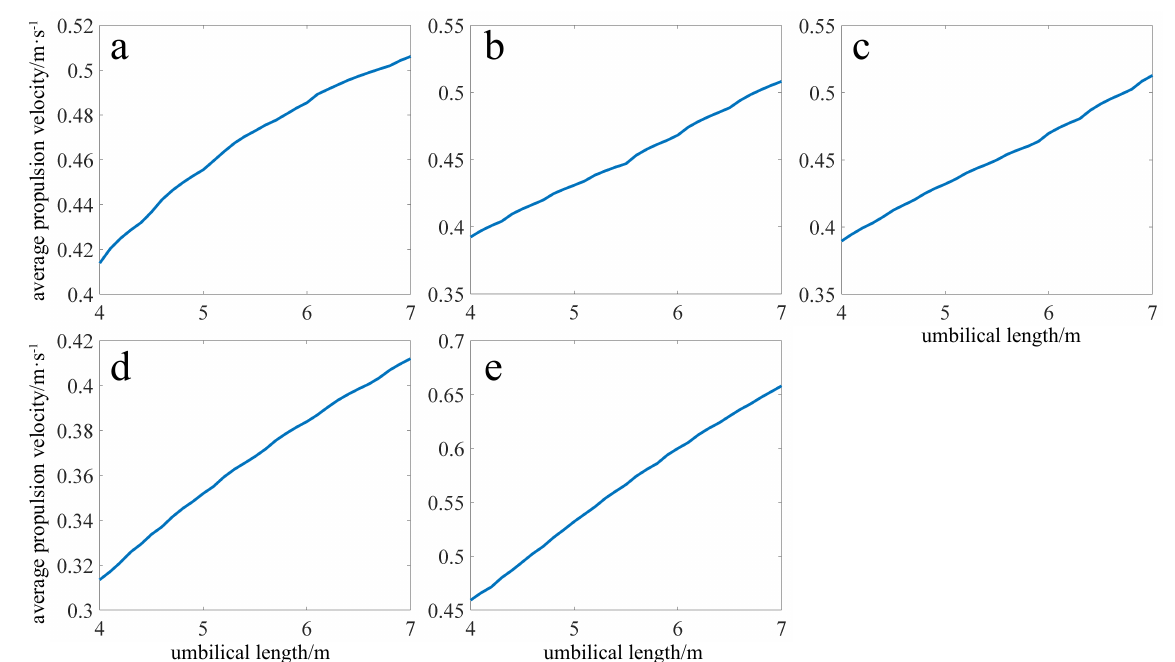
Figure 6. Variation in the average propulsion velocity with the umbilical length: ( a ) first type, ( b ) second type, ( c ) third type, ( d ) fourth type, and ( e ) fifth type.